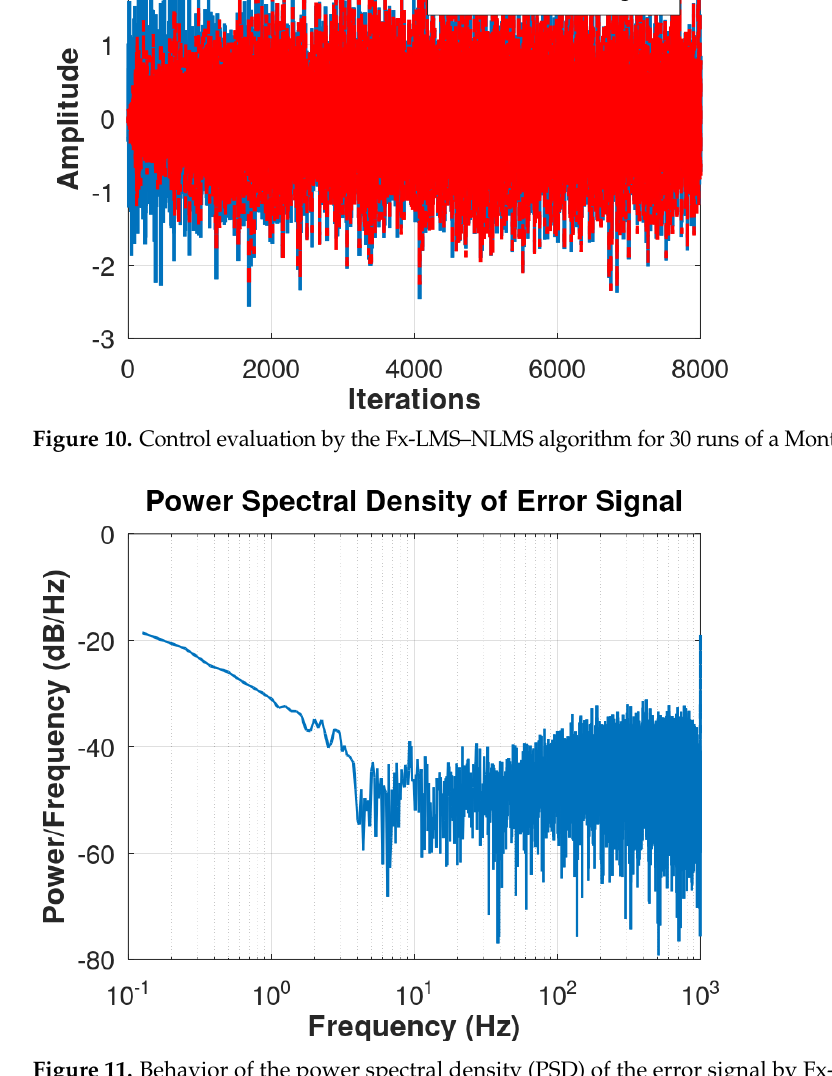
Figure 11. Behavior of the power spectral density (PSD) of the error signal by